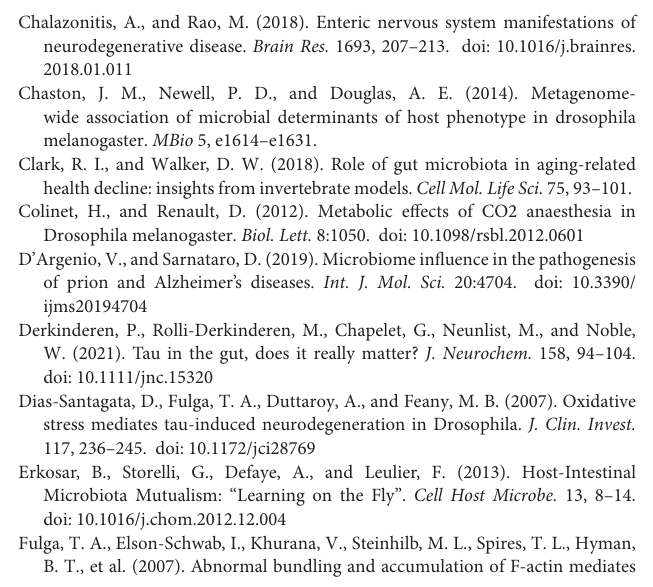
Supplementary Figure 1 | Neuronal overexpression of eGFP and SCA3 shows no significant differences in gastric emptying at 10 day. eGFP and SCA3 transgenic flies show no difference in time to gastric emptying compared to controls (A) ( n = 6, ANOVA, p > 0.05). These results are supported by similar retention of blue food in the abdomen in a gastric emptying time course (B) . Data are shown as average ± SEM. Supplementary Table 1 | Bacteria identified by 16S rDNA sequencing in fly